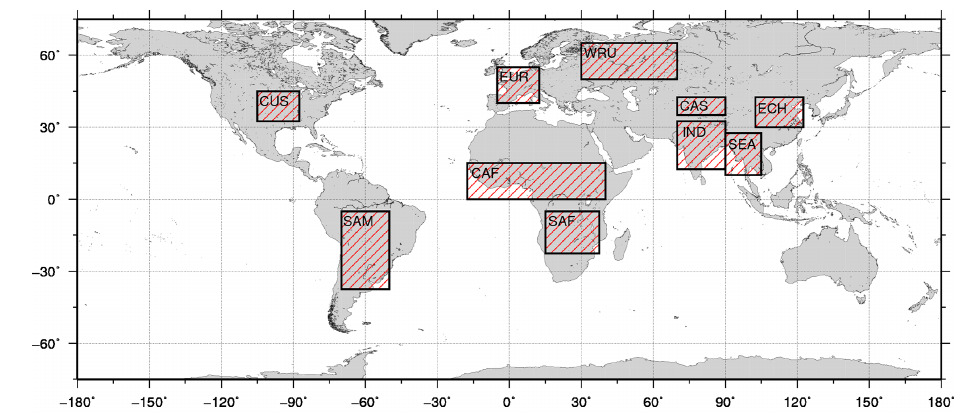
Figure 5. Distribution of areas with high ammonia concentrations obtained from GOSAT.